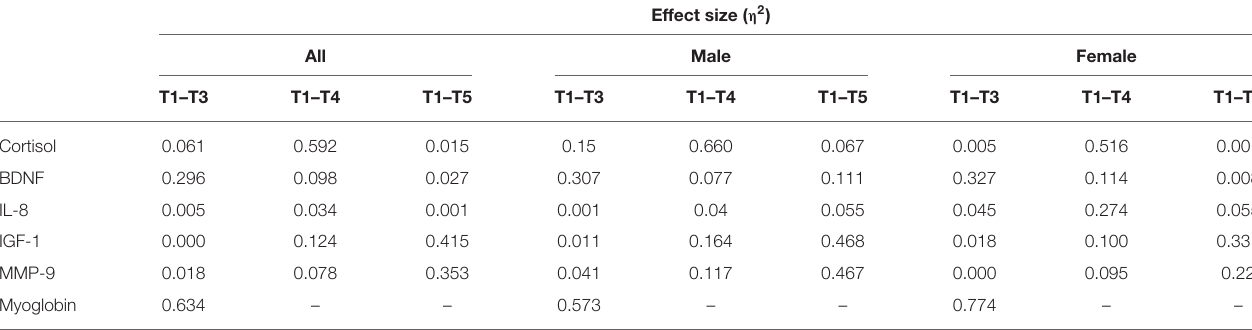
TABLE 2 | Effect size of biological parameters in all, male, and female participants between T1 and T3, T1 and T4, and T1 and T5.